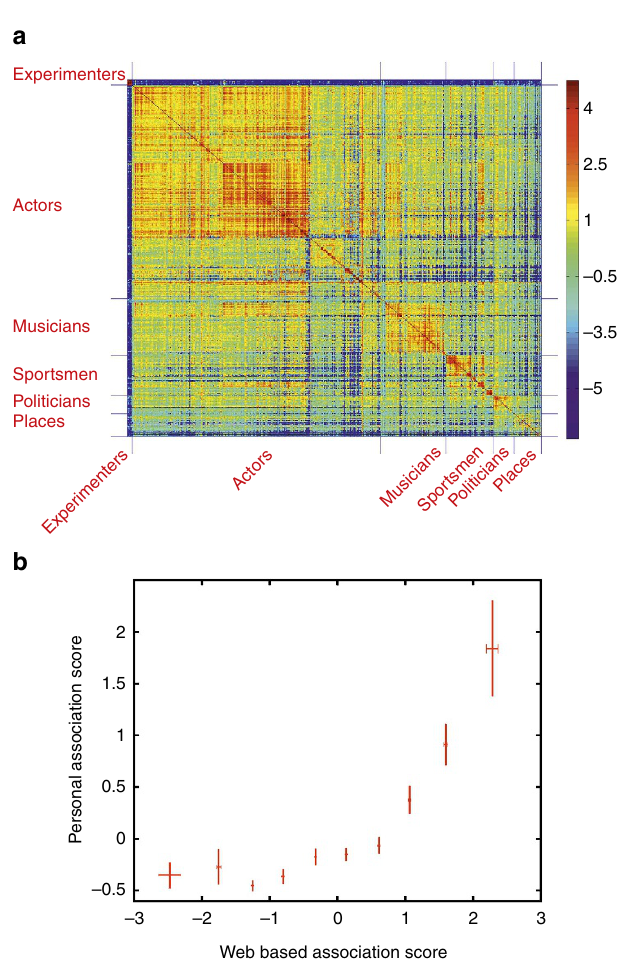
Figure 2 | Web-association matrix and correlation with personal scores. ( a ) Web-association values between the 611 stimuli presented in the screening sessions. Note the clustering of values according to the broad categories of the images (manually assigned categories are shown on the left/bottom). The colour bar on the right shows the strength of association values in arbitrary units. ( b ) Correlation between the personal and the web- based association scores (see text for details; mean ± s.e.m.).